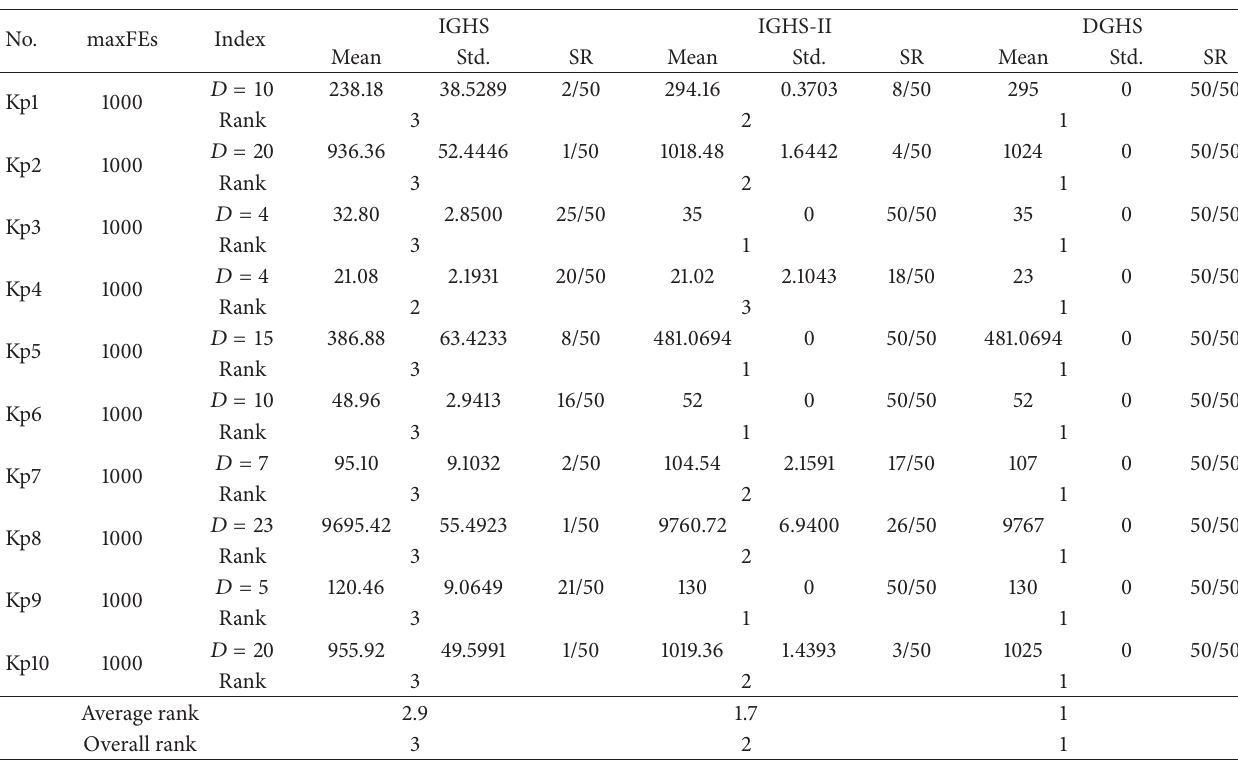
Table 6: Comparison among DGHS and IGHS together with IGHS-II on ten knapsack